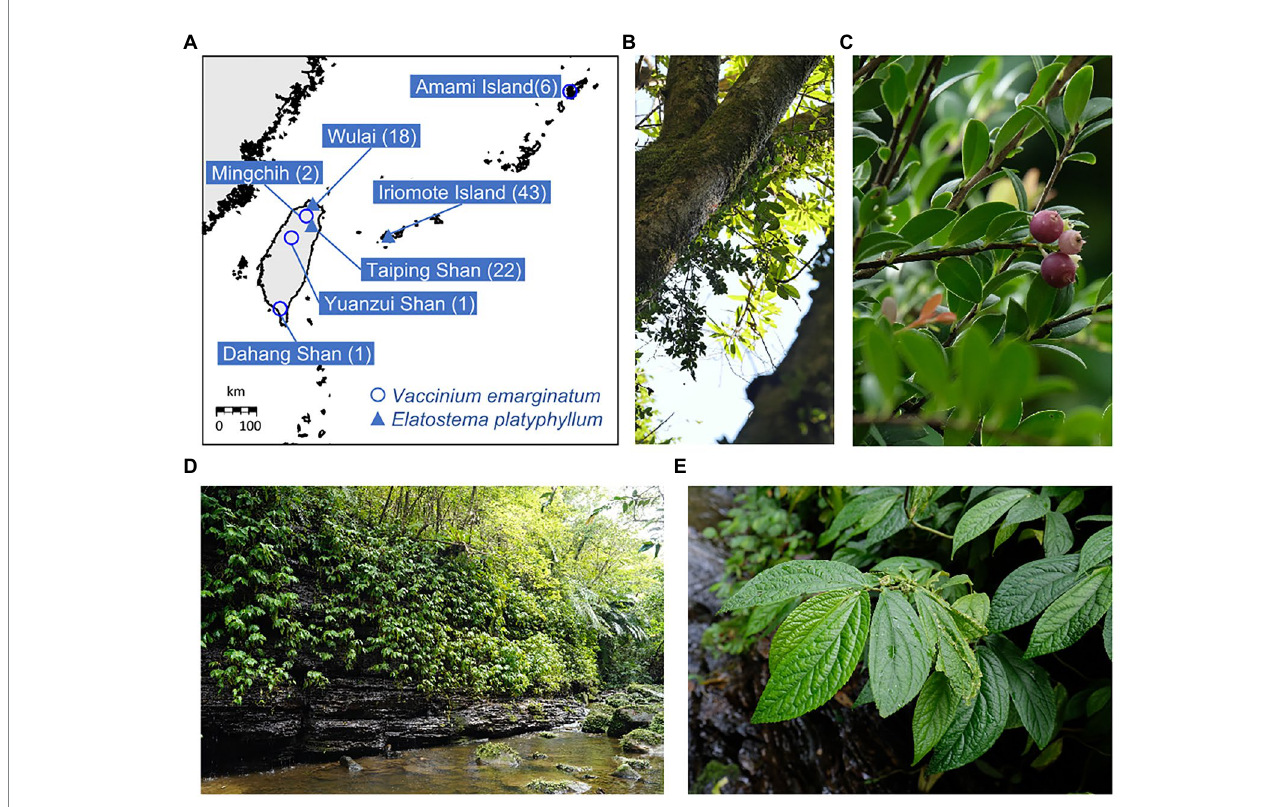
FIGURE 1 (A) Sampling sites of Vaccinium emarginatum ( ○ ) and Elatostema platyphyllum ( ▲ ). The numbers of samples are indicated in the parentheses. (B) A habitat of V. emarginatum in Amami Island. This species prefers to grow on the upper part of the trunks. (C) A plant of V. emarginatum producing fruits. (D) The sampling location of E. platyphyllum on Iriomote Island. (E) A plant of E. platyphyllum in its habitat on Iriomote